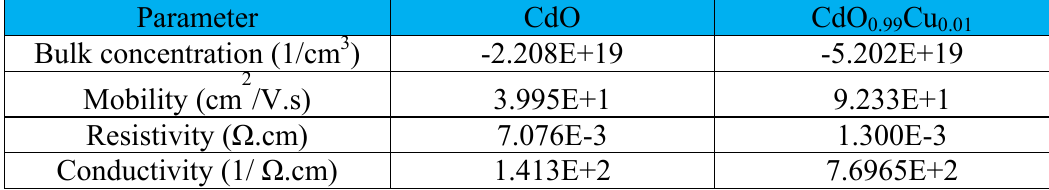
Table 2: Hall measurement for CdO and CdO